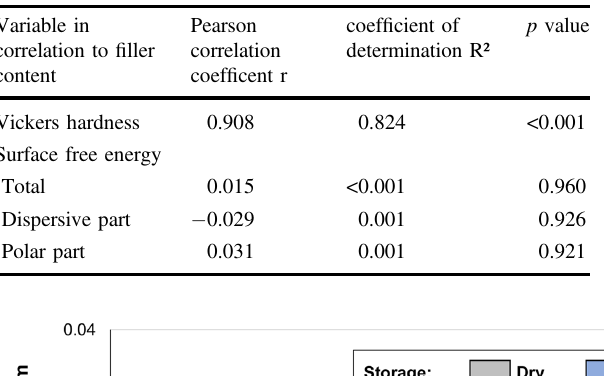
Table 3 Pearson correlation of the investigated variable Vickers hardness and surface free energy to the fi ller contents of the investigated CAD/CAM resin composite determined by Koenig et al. [6] Variable in correlation to fi ller